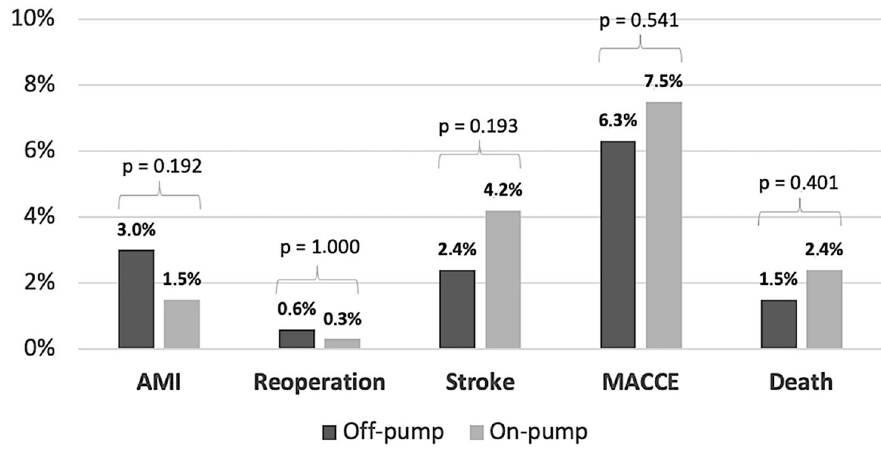
Fig. 2 – Thirty-day outcomes rates stratified by cardiopulmonary bypass support. AMI=acute myocardial infarction; MACCE=major adverse cardiovascular and cerebrovascular